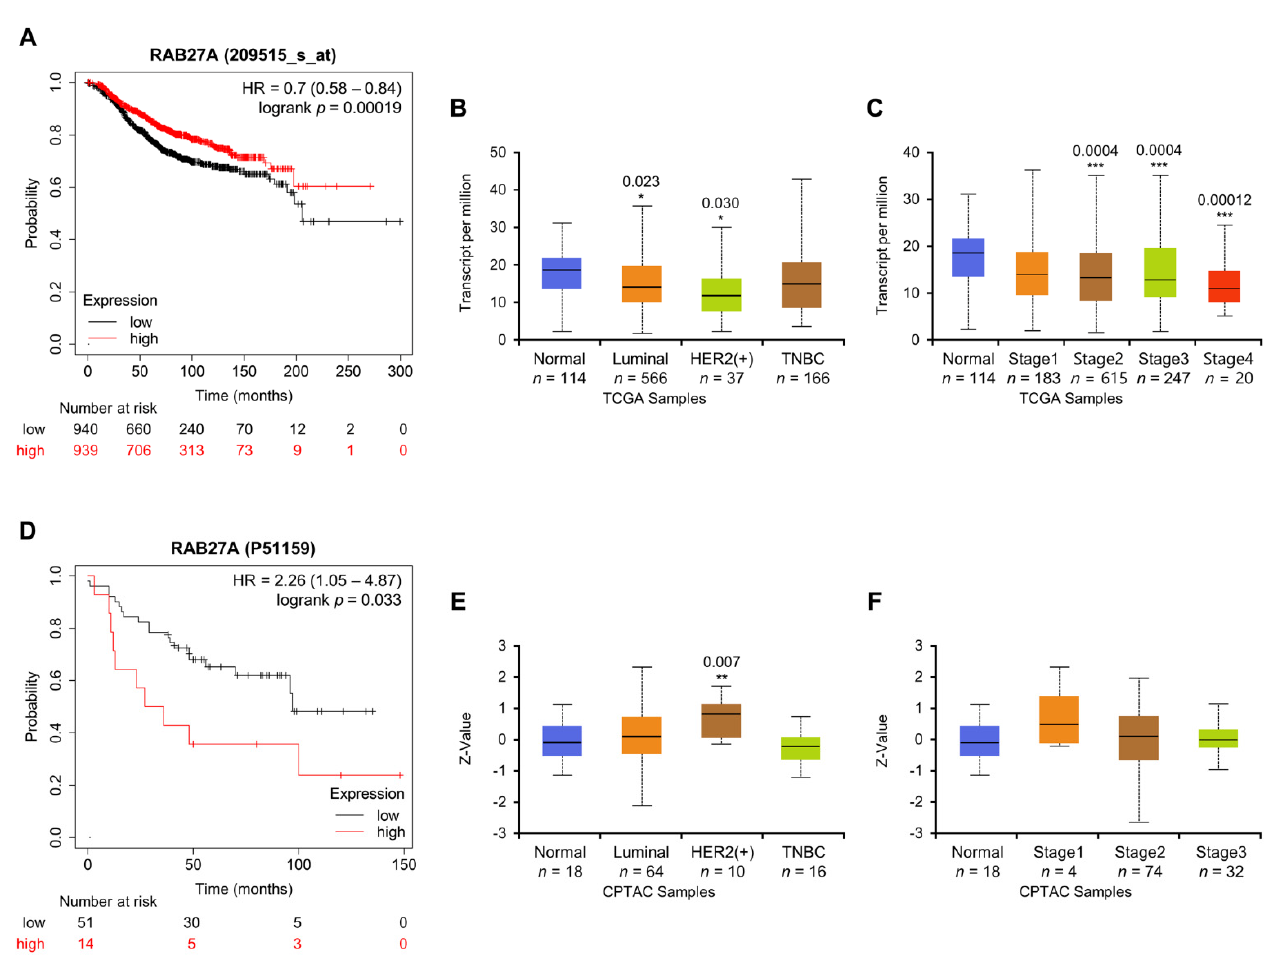
Figure 7. Clinical significance of Rab27a mRNA and protein expression levels. ( A ) Effect of Rab27a mRNA on OS of breast cancer patients, using Kaplan-Meier Plotter analysis. The image with the lowest logrank p value is represented. The red and black lines indicate high and low Rab27a expres- sion, respectively. ( B , C ) Rab27a mRNA expression levels in ( B ) major subclasses of breast cancer or ( C ) different breast cancer stages were analyzed with the UALCAN tool using TCGA BRCA dataset. ( D ) the overall survival rate of breast cancer patients based on Rab27a expression at the protein level was analyzed using the Kaplan-Meier Plotter. ( E , F ) The expression level of Rab27a protein accord- ing to ( E ) major subclasses or ( F ) stages of breast cancer was analyzed with UALCAN tool using the CPTAC breast cancer dataset. Boxplot represents median with upper and lower quartiles, and the bars represent the maximum and minimum values. Compared with the normal tissue control group, statistically significant differences were indicated as * p < 0.05, ** p < 0.01, and *** p < 0.001.